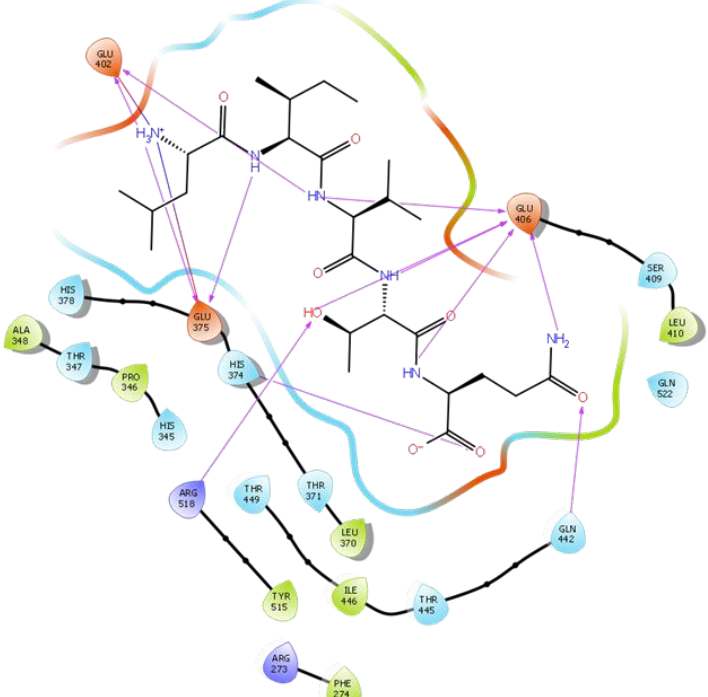
Figure 5. Docking results of the peptide LIVTQ in the human ACE2 active site. The interactions of human ACE2 residues with the peptide LIVTQ (represented in black) are indicated by arrows of different colors, with purple arrows representing hydrogen bond interactions and blue arrows representing salt bridge interactions.